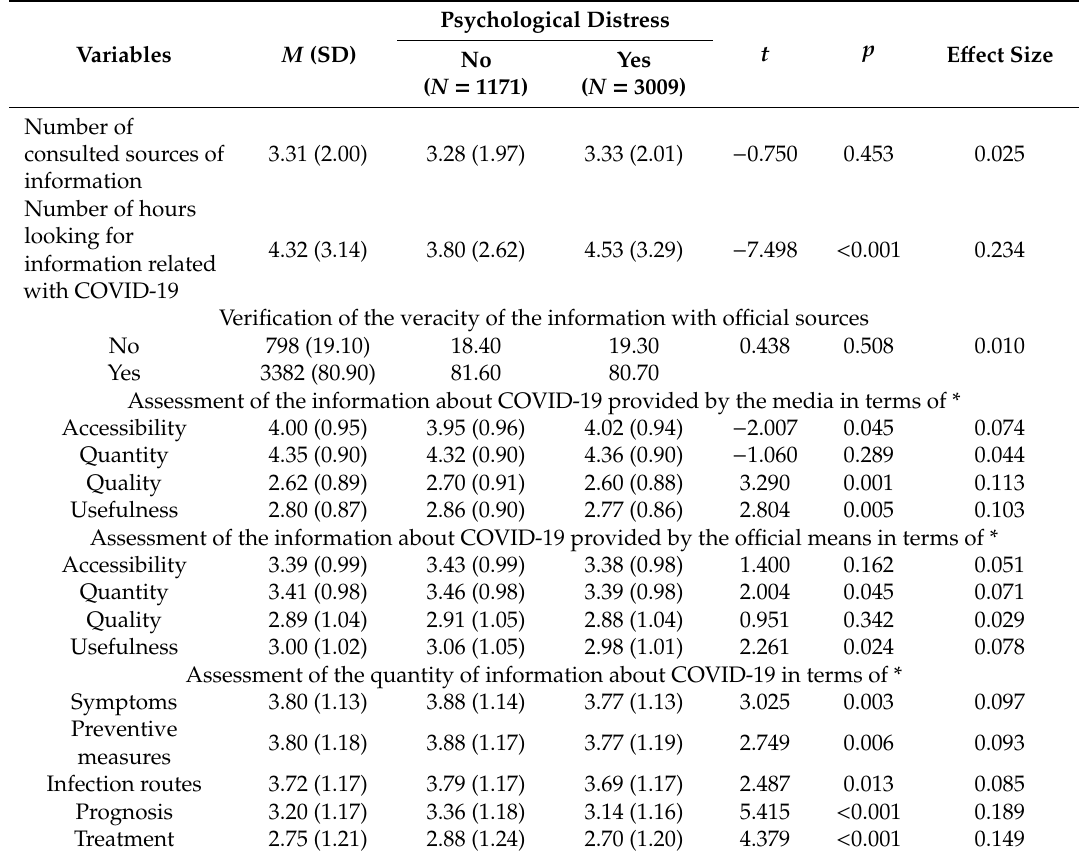
Table 2. Association between information about coronavirus disease (COVID-19) and psychological distress during the pandemic ( n =